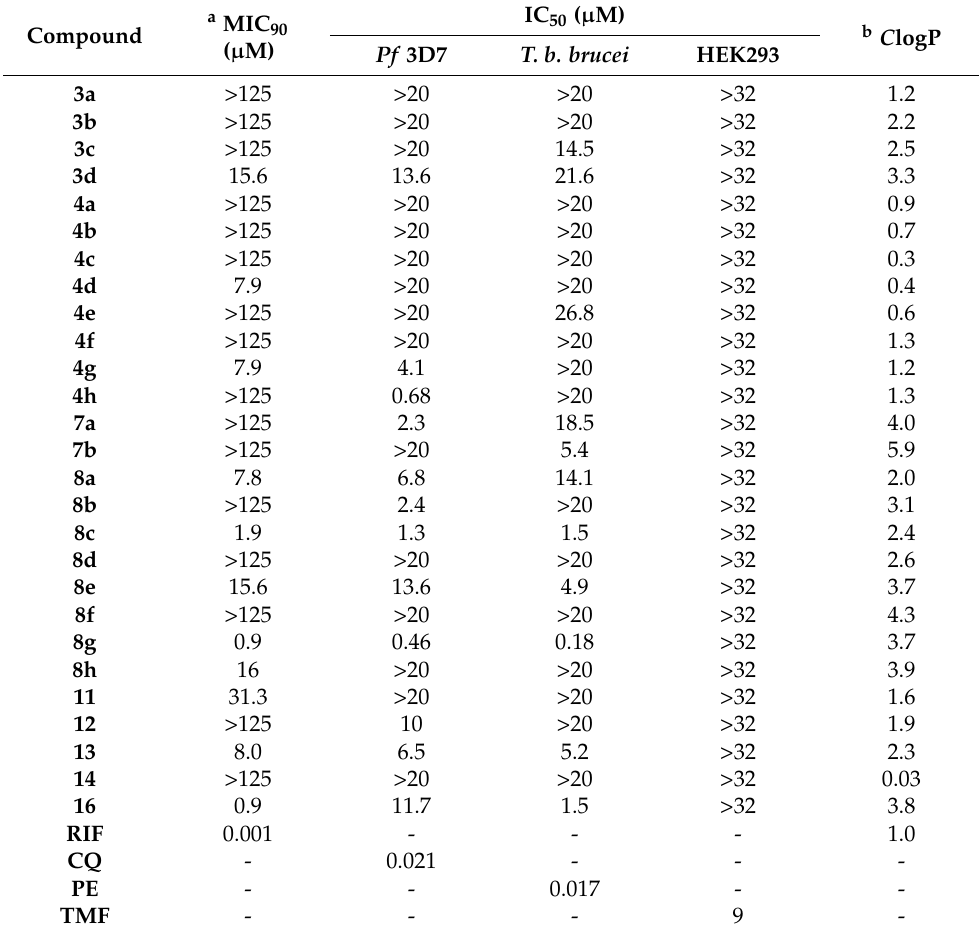
Table 1. ClogP, In vitro anti- Mtb , anti-plasmodial, anti-trypanosomal and cytotoxic